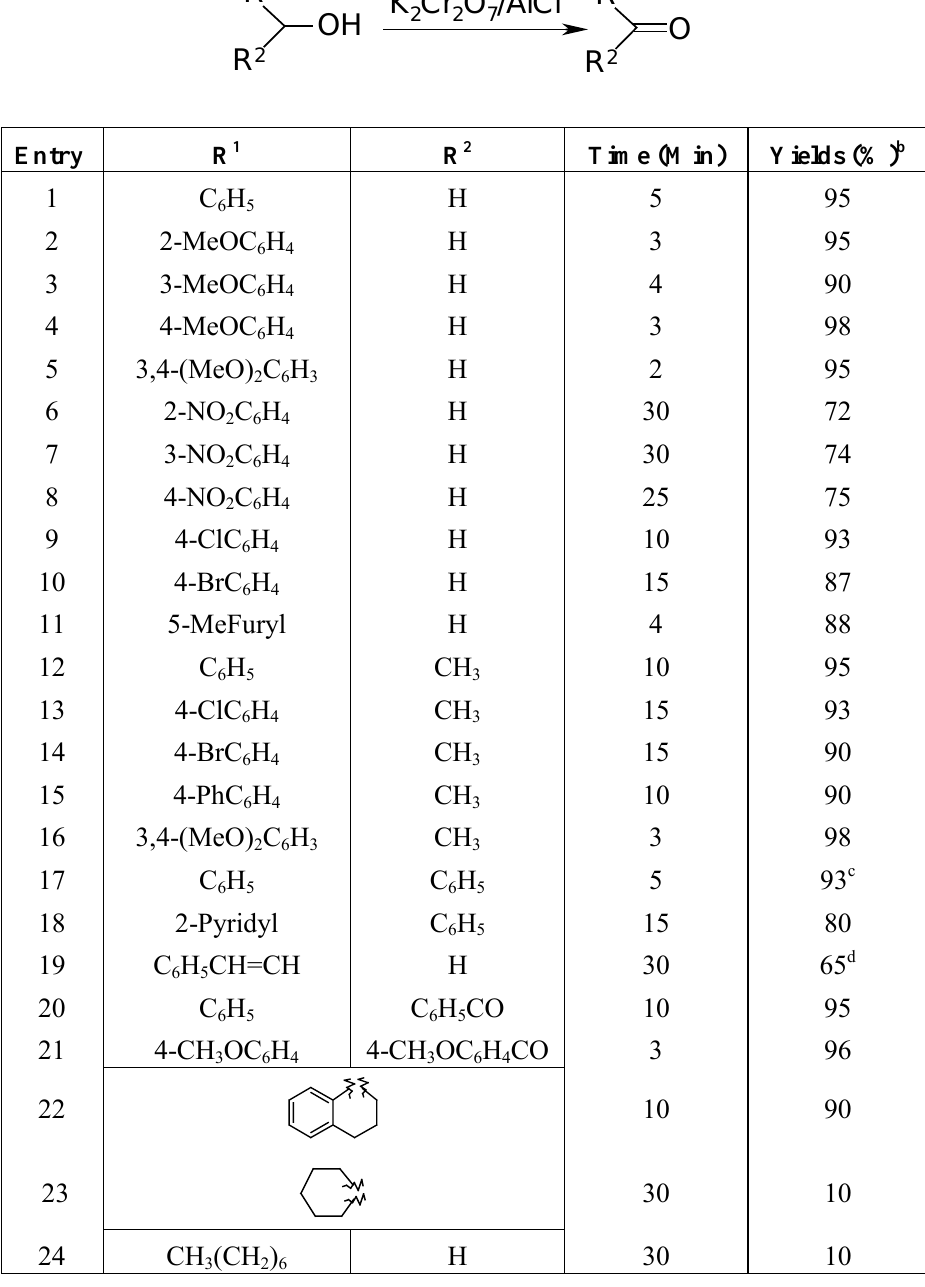
Table 2. Oxidation of Alcohols to Carbonyl Compounds